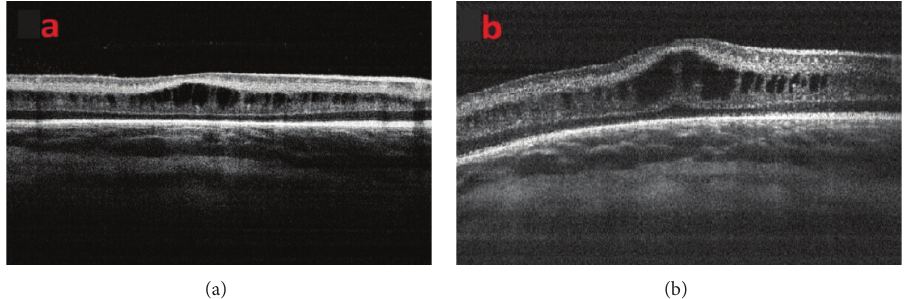
Figure 6: (a) OCT image of a premature infant with type 1 ROP (zone 2 stage 3 with plus disease) before intravitreal ranibizumab treatment and (b) one week after intravitreal ranibizumab treatment.